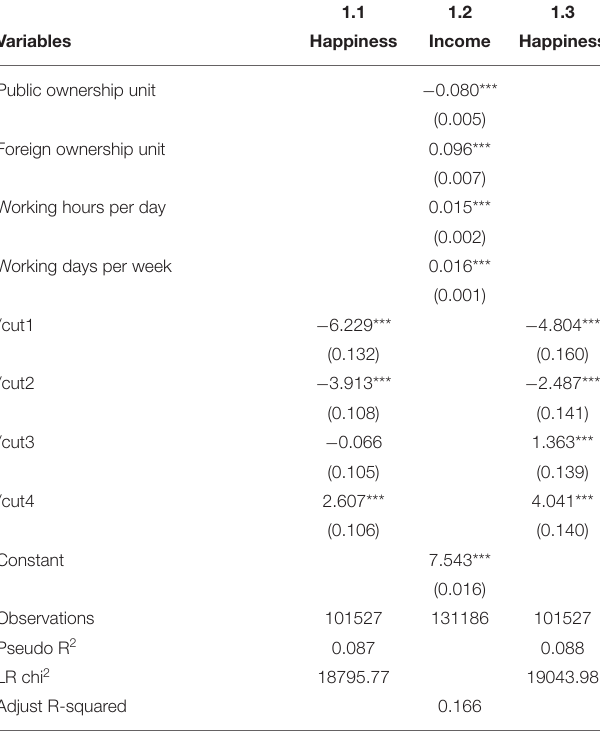
TABLE 2 | The mediating effect model estimation results of education on